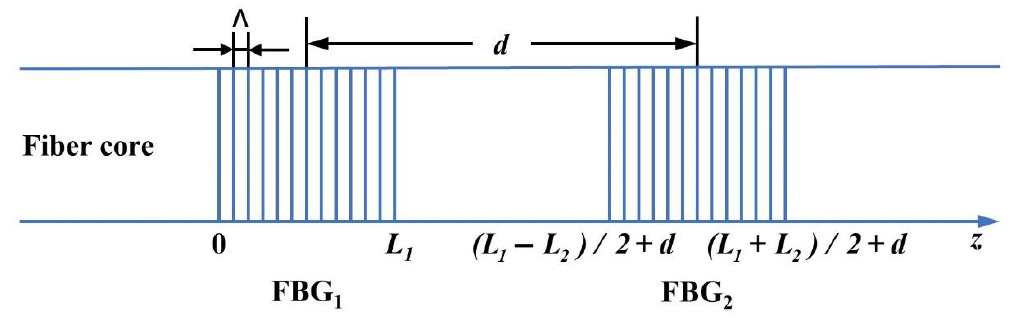
Figure 1. Schematic of a FBGs-based FPC.